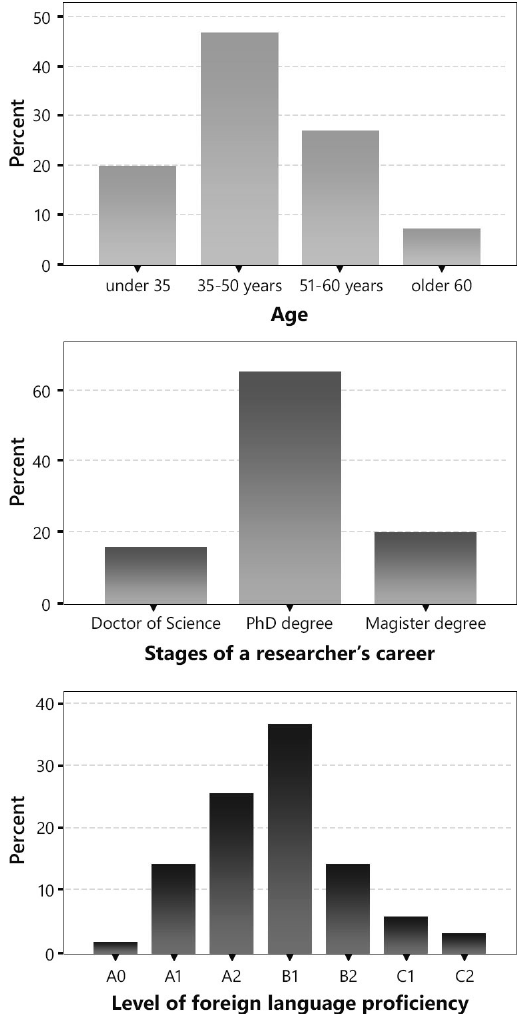
Figure 1. Respondents’